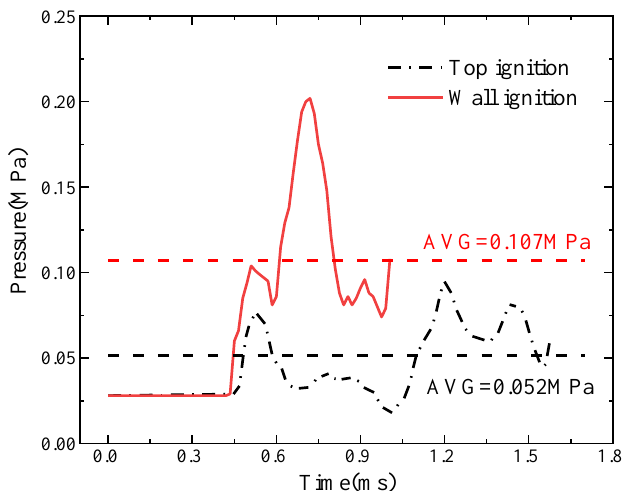
Figure 13. Pressure changes of two ignition positions at the exit of the hot jet tube.